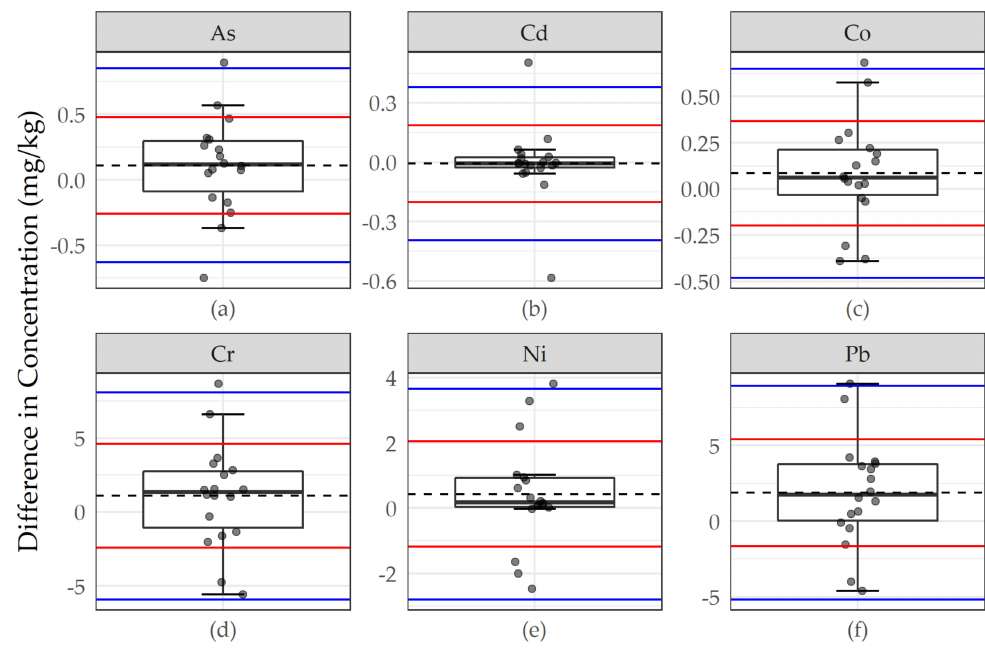
Figure 2. Differences in concentration in youth scientists’ primary and replicate moss samples for ( a ) As, ( b ) Cd, ( c ) Co, ( d ) Cr, ( e ) Ni, and ( f ) Pb. Points represent paired differences, summarized by underlying boxplots. Dashed lines represent the mean paired difference between primary and replicate samples; red and blue lines represent “bounds of agreement” at ± 1 and ± 2 standard deviations, respectively, about the mean difference. Arsenic (As), cadmium (Cd), cobalt (Co), chromium (Cr), nickel (Ni), and lead (Pb).